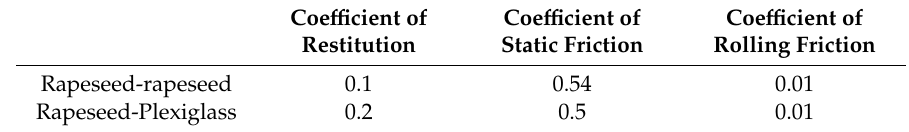
Table 3. Contact parameter.